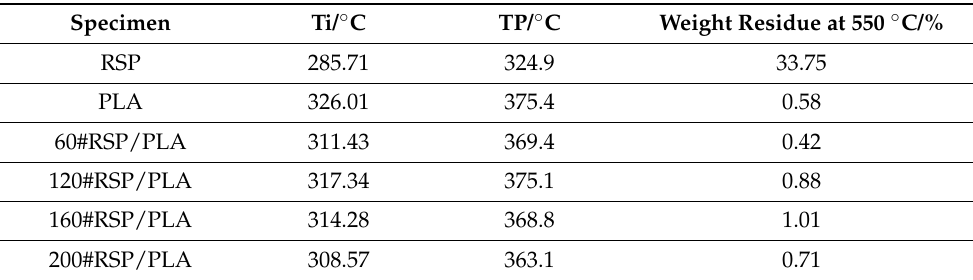
Table 1. Thermal decomposition parameters for 3D-printed PLA and RSP/PLA composites in a nitrogen